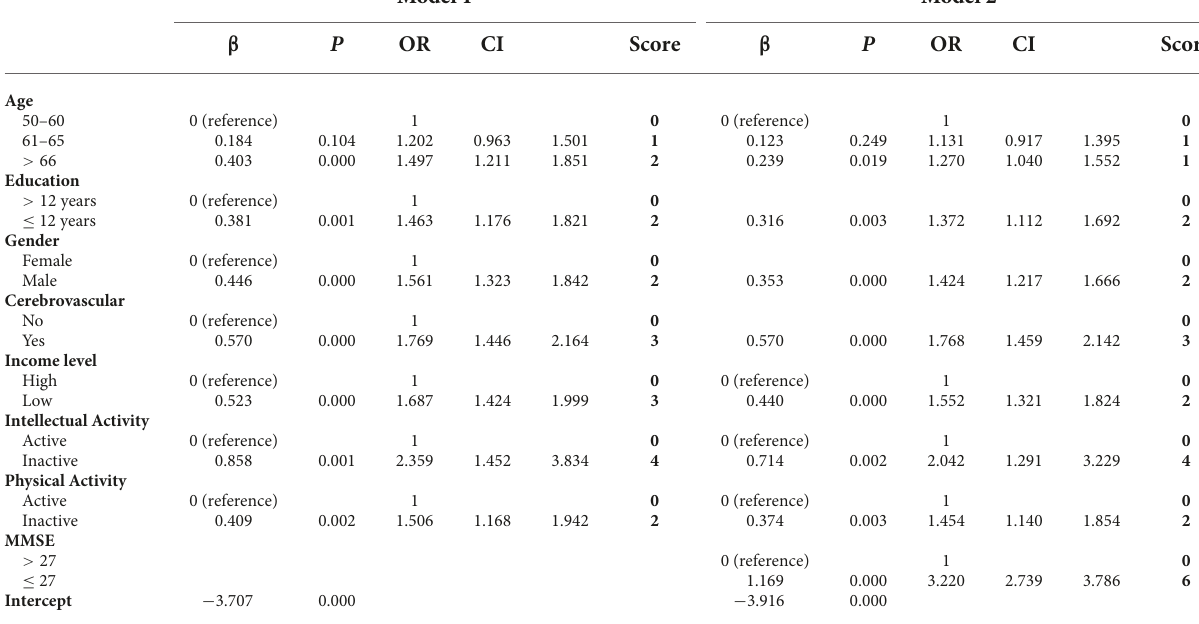
TABLE 2 Logistic regression models for MCI risk according to the selected risk factor.